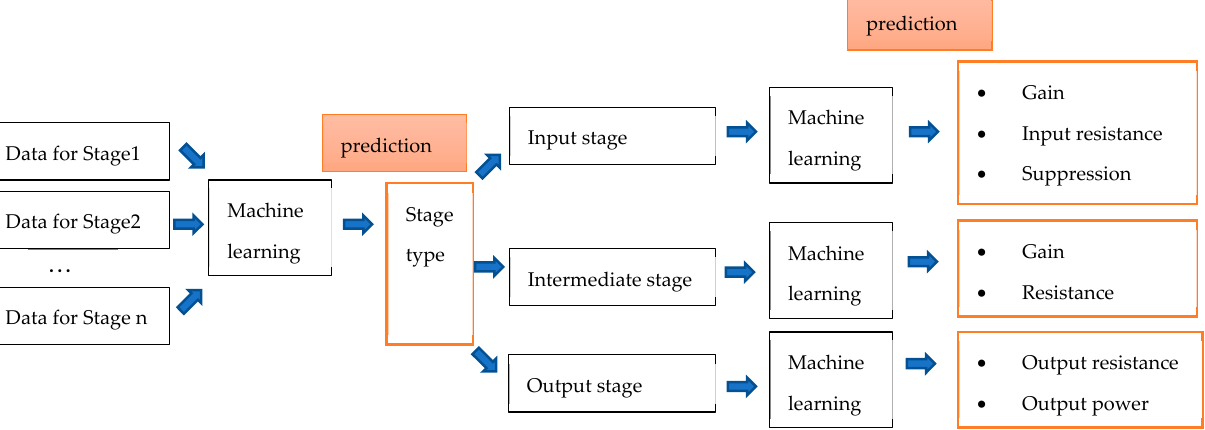
Figure 5. Method for amplifier design through machine learning.